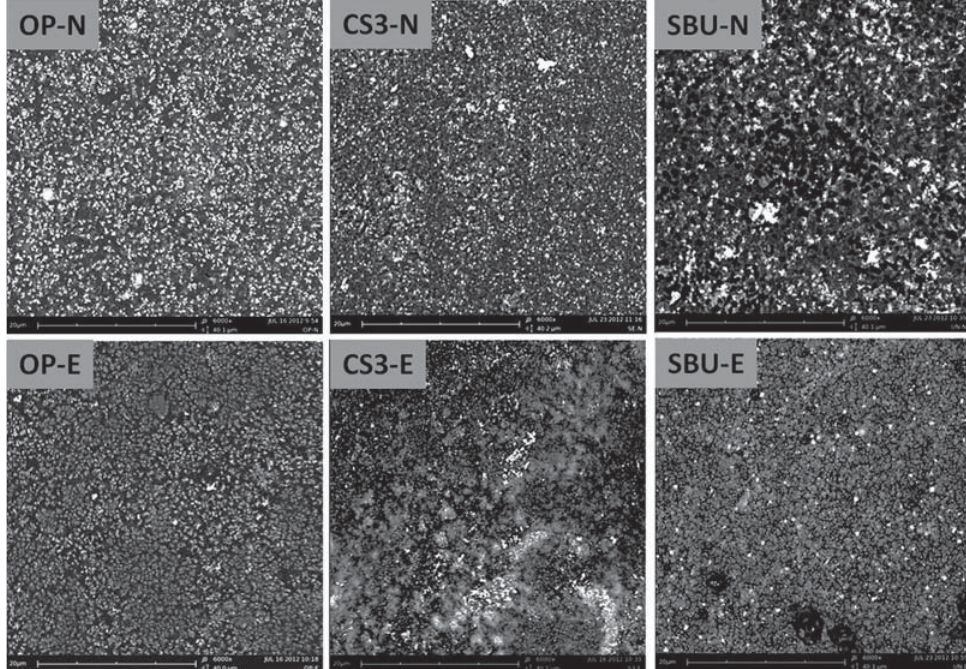
Figure 3- (cid:8)Z(cid:5)(cid:13)(cid:12)(cid:3)(cid:4)(cid:5)~(cid:5)(cid:28)(cid:4)(cid:8)(cid:12)’(cid:8)(cid:25)(cid:20)(cid:4)(cid:8)(cid:5)(cid:14)(cid:20)(cid:4)(cid:23)(cid:17)Y(cid:4)(cid:23)(cid:8)\*(cid:25)(cid:17)‘(cid:12)(cid:13)(cid:14)(cid:8)(cid:9)(cid:12)(cid:3)(cid:12)(cid:8)^(cid:3)(cid:18)(cid:23)(cid:8)(cid:15)\^(cid:16)j(cid:8)(cid:2)(cid:3)(cid:4)(cid:5)(cid:6)(cid:7)(cid:3)(cid:8)(cid:9)|(cid:8)(cid:11)(cid:12)(cid:13)(cid:14)(cid:8)(cid:15)(cid:2)(cid:9){(cid:16)j(cid:8)(cid:5)(cid:13)(cid:14)(cid:8)(cid:9)(cid:24)(cid:12)(cid:25)(cid:24)(cid:20)‘(cid:12)(cid:13)(cid:14)(cid:8)}(cid:13)(cid:17)Y(cid:4)(cid:6)(cid:23)(cid:5)(cid:3)(cid:8) Adhesive (SBU) with the solvent non-evaporated (N) or evaporated (E) after 7 days of water storage. The more intense silver uptake is evident for the non-evaporated